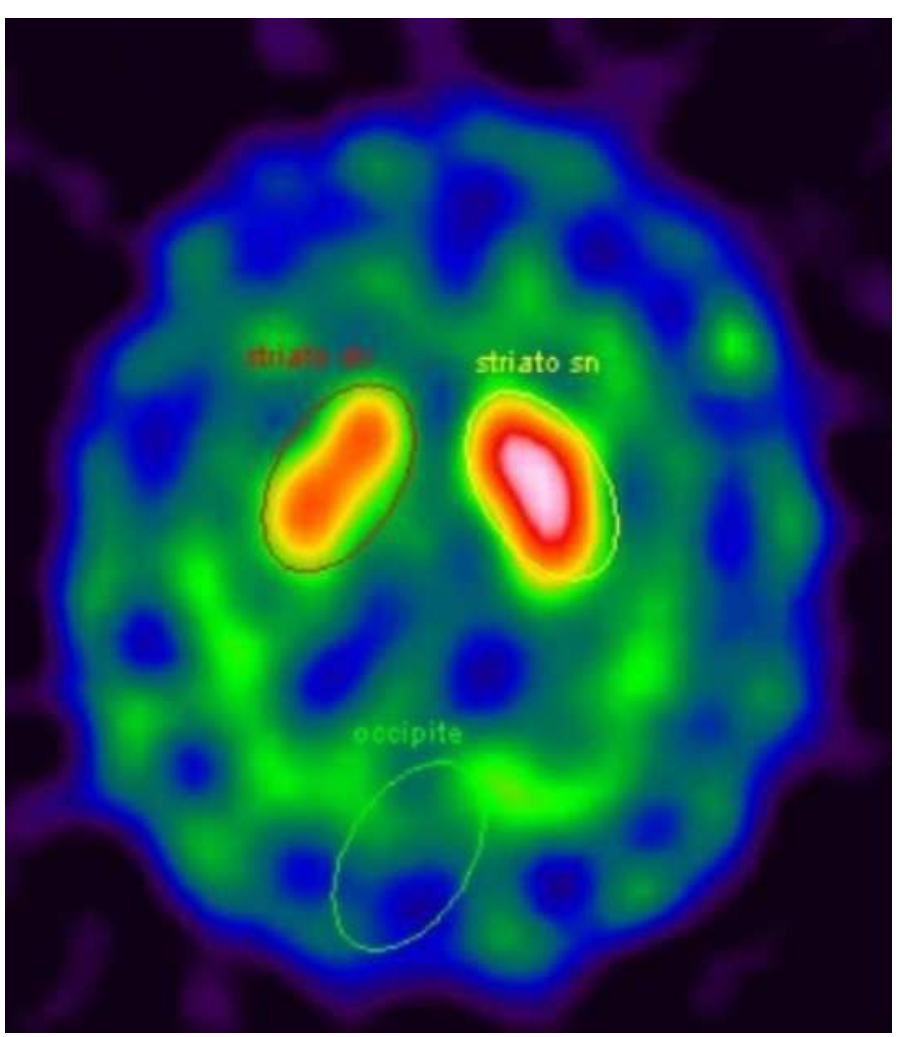
Figure 1. DaT-Scan SPECT showing asymmetric reduction of dopamine transporters in right stri- atum.